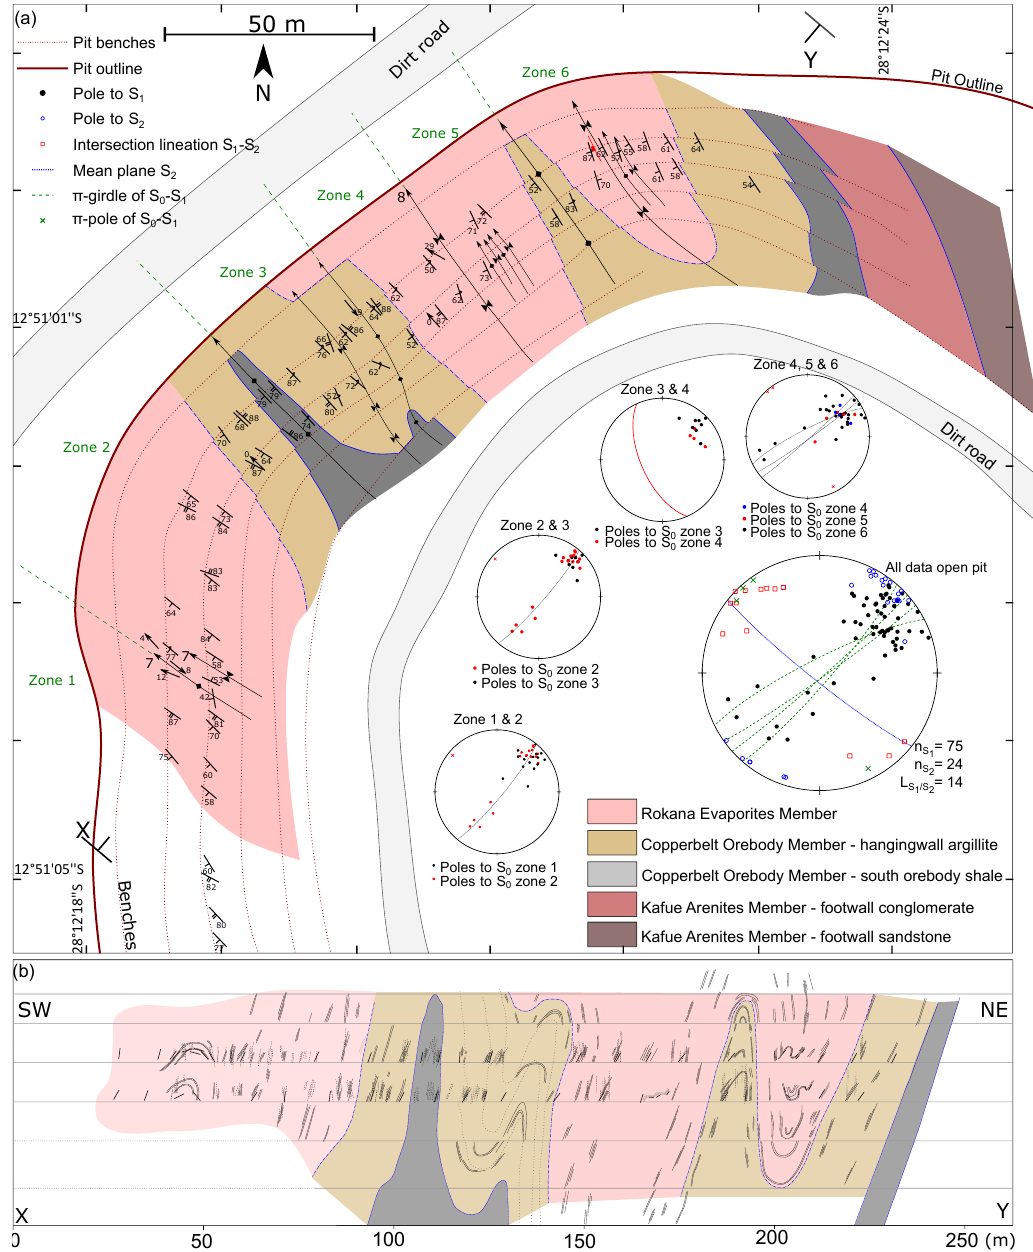
Figure 8. (a) Geological map of the west side of the Nkana South open pit (section 8). Lower-hemisphere equal-area stereoplots refer to particular zones in the pit. Data and statistics on zones, girdles and π axes to S 1 cleavage are given in the Supplement. (b) Cross-section is perpendicular to the structural trend in the open pit and without height